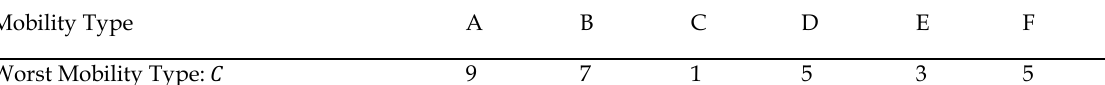
Example of evaluating all mobility types comparing to the worst mobility